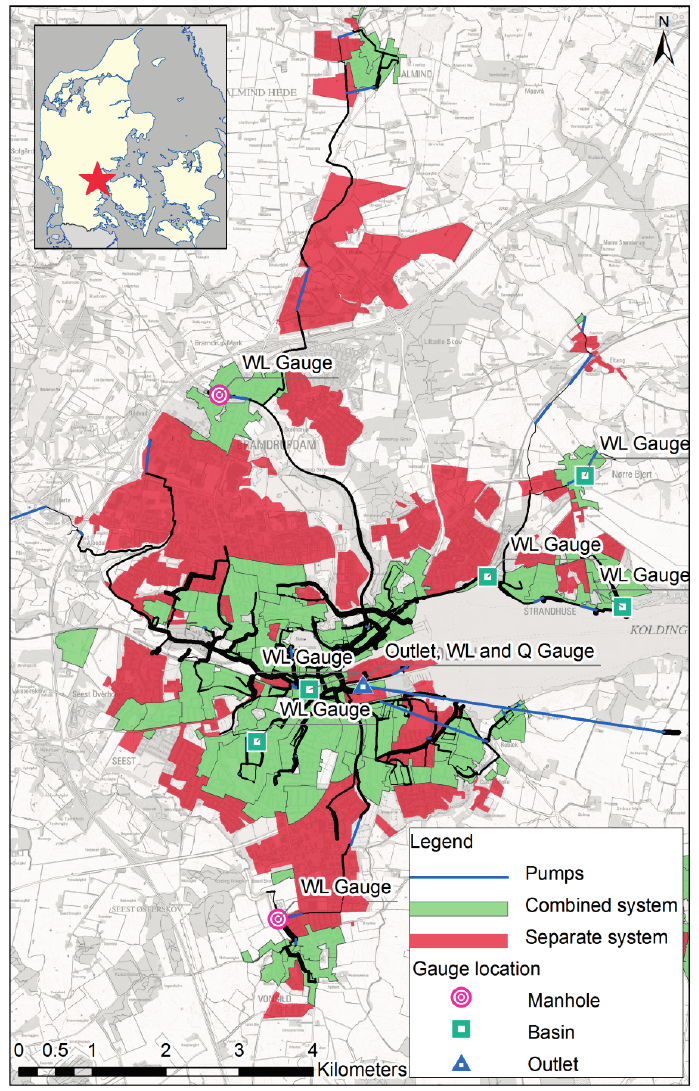
Figure 6. Overview of the distributed urban drainage model for Kolding. The squares, dots and triangles indicate where the observations from the six basins, two manholes and the outlet are located. The green and red areas indicate whether stormwater and wastewater flow in the same pipe (green, the system is combined) or in different pipes (red, the system is separated). Small villages that contribute to the flow are not included on the